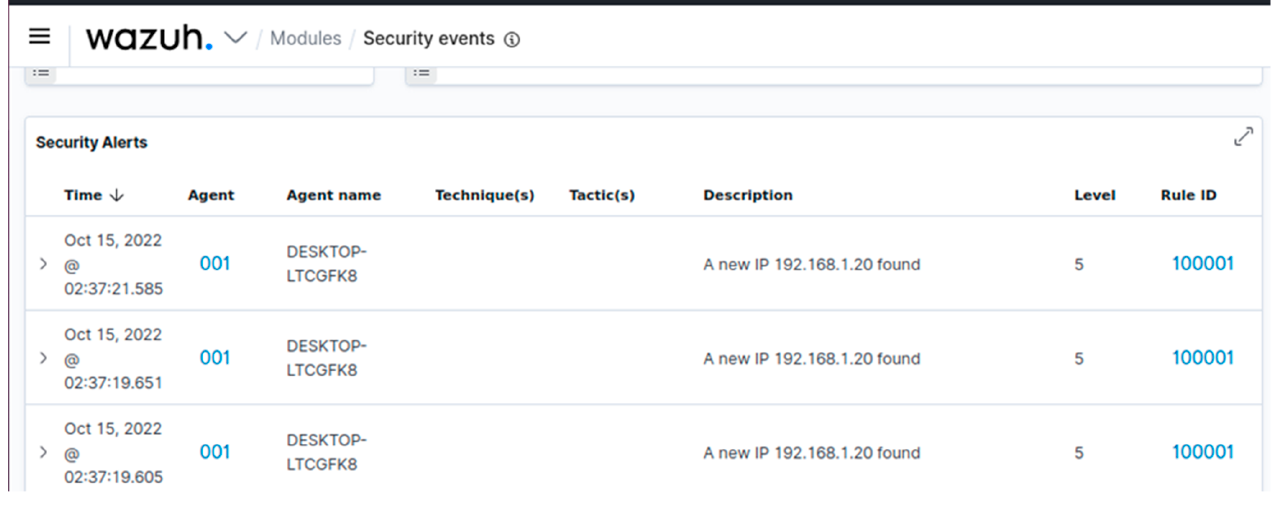
Figure 17. Intrusion Alerts.